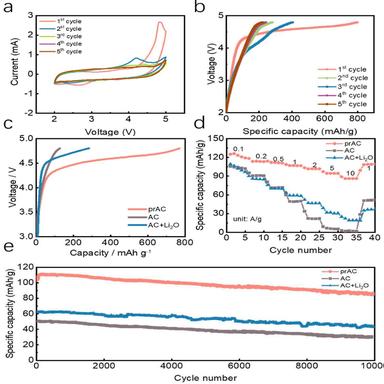
(a) CV curves of the prAC cathode of the first five cycles; (b) GC curves of the prAC cathode of the first five cycles; (c) GC curves of the prAC, AC, and AC + Li2O cathodes of the first cycle; (d) rate performances of the prAC cathode after prelithiation, AC and AC + Li2O cathode; (e) cycle performance of the prAC cathode after prelithiation, AC and AC + Li2O cathodes at a density of 1 A/g for 10,000 cycles. CV: cyclic voltammetry; GC: gas chromatography; AC: activated carbon.